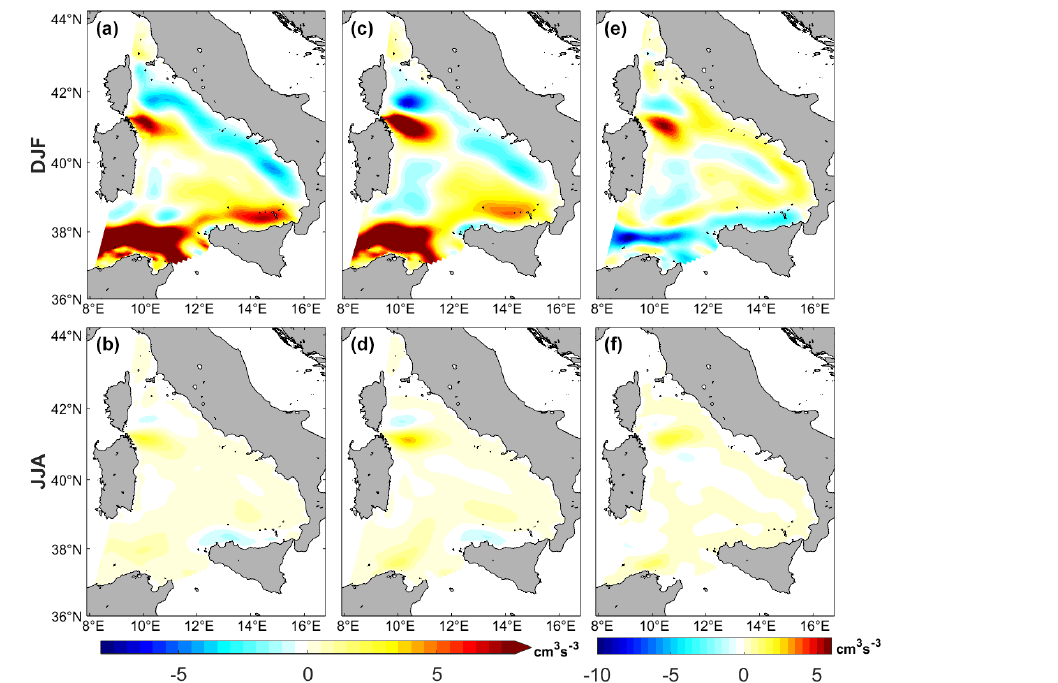
Figure 11. Winter (a, c, e) and summer (b, d, f) averages of the wind work (cm 3 s − 3 ) taking into account ocean currents averaged from the surface to a depth of 51m for present (a, b) and future (c, d) climate as computed from ROM. Differences between the wind work in the future and present climate are presented in panels (e) and (f)